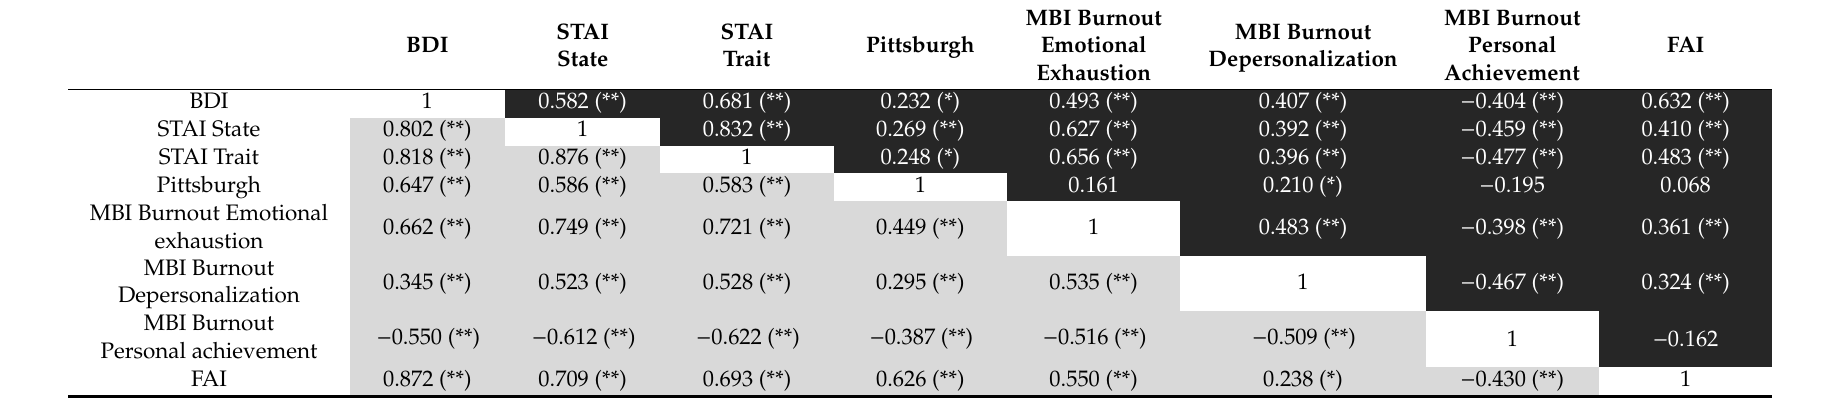
Table 3. Pearson’s correlations in different contractual figures.